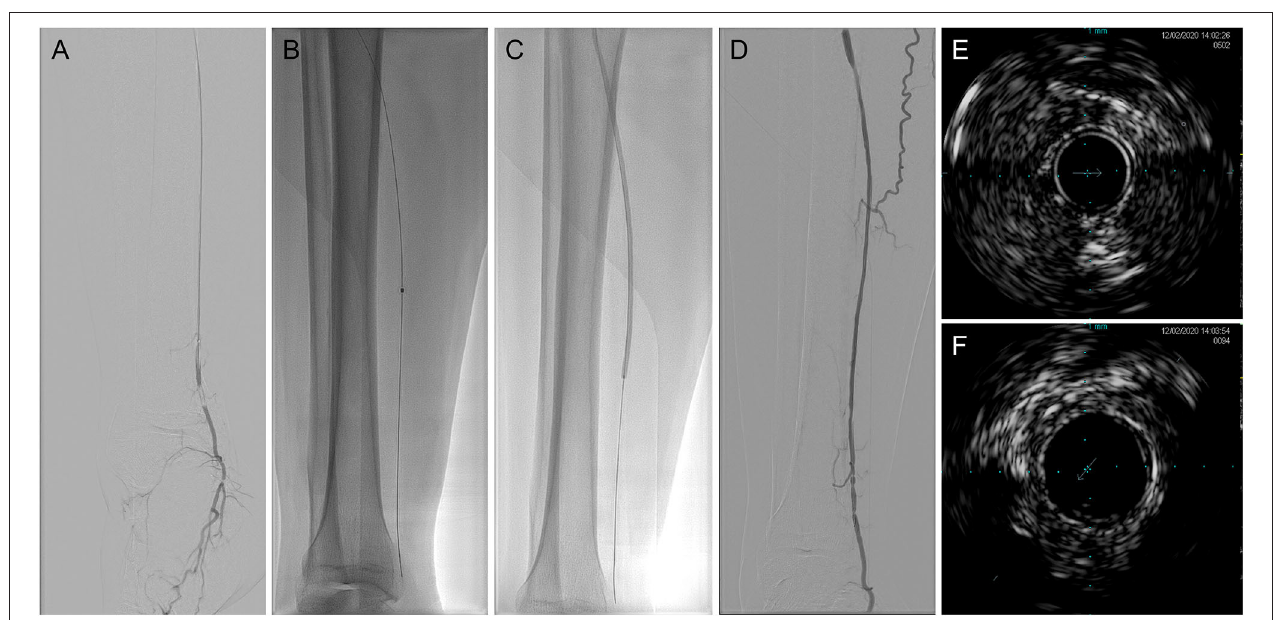
FIGURE 1 | Representative digital subtraction angiography (DSA) and intravenous ultrasound (IVUS) imaging of laser-assisted angioplasty intervention. (A) Baseline angiography; (B) excimer laser angioplasty; (C) balloon angioplasty (BA); (D) after intervention angiography; (E) baseline IVUS imaging; and (F) after intervention IVUS imaging. DSA, digital subtraction angiography; IVUS, intravenous